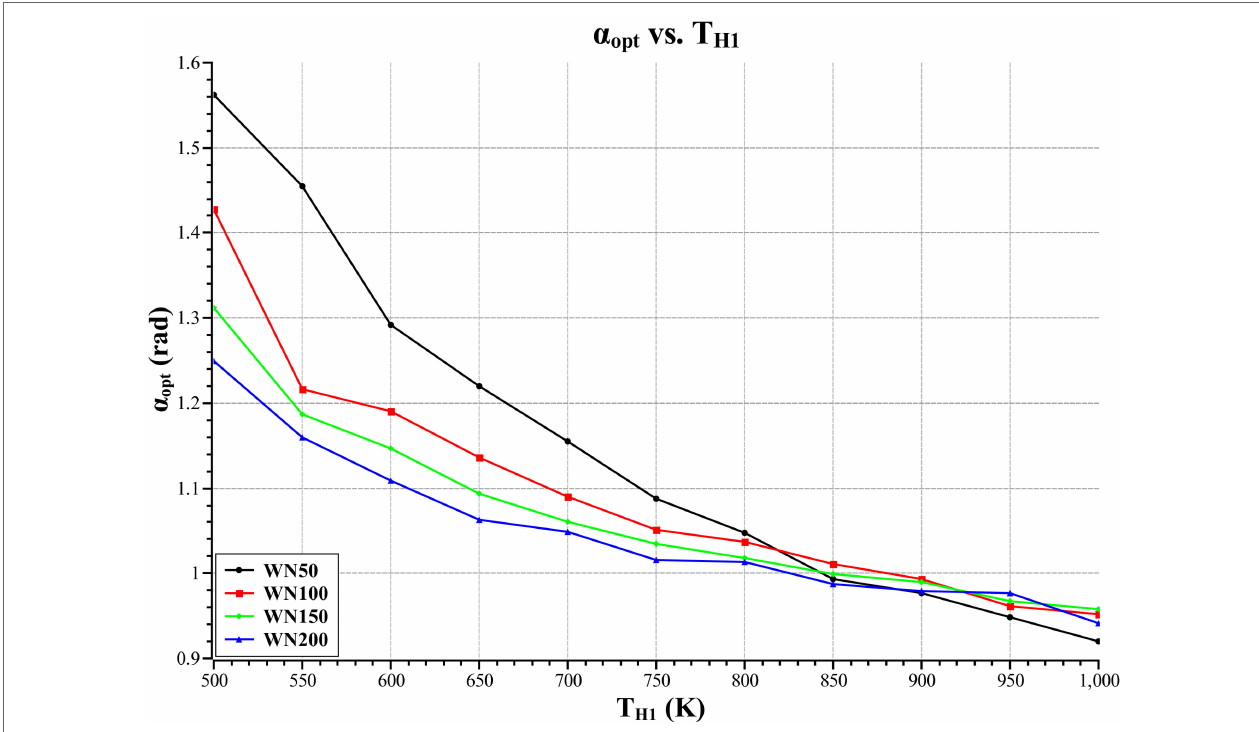
FIGURE 13 | Optimal phase difference versus heater inlet temperature.